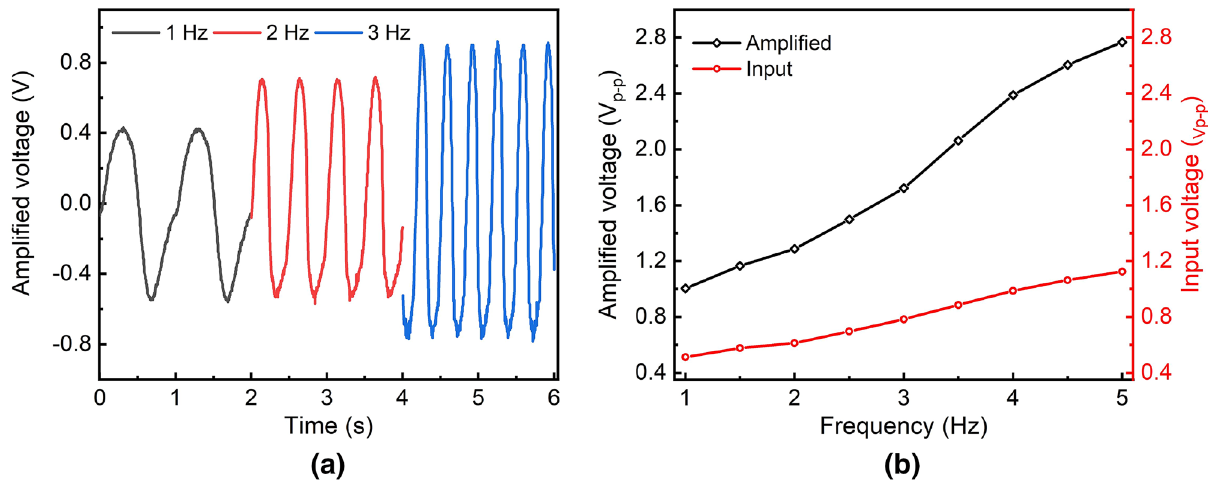
Figure 10. ( a ) Reconstructed amplified signal at the receiver for 1.0–3.0 Hz, ( b ) Amplified output of the charge amplifier and input voltage from the